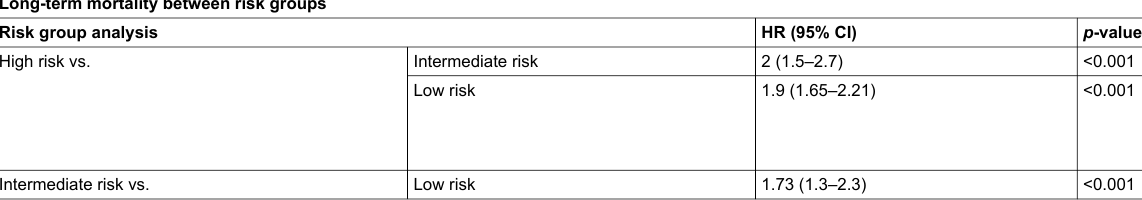
Table 4: Cox regression analysis with corresponding HR (95% CI) of all risk